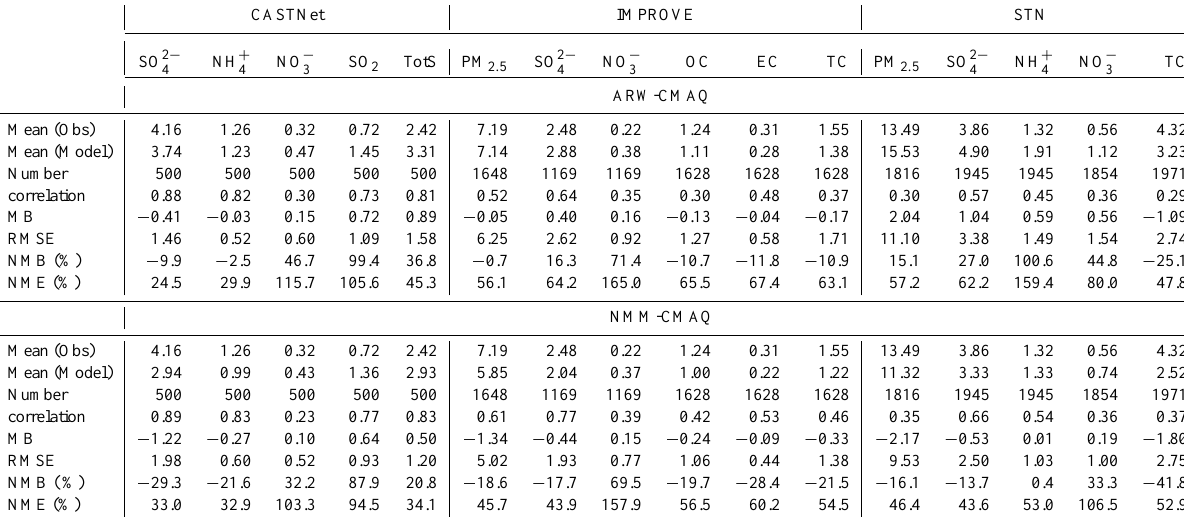
Table 2. Comparison of ARW-CMAQ and NMM-CMAQ models for PM 2 . 5 and its components for each network over the eastern United States during the 2006 TexAQS/GoMACCS period.